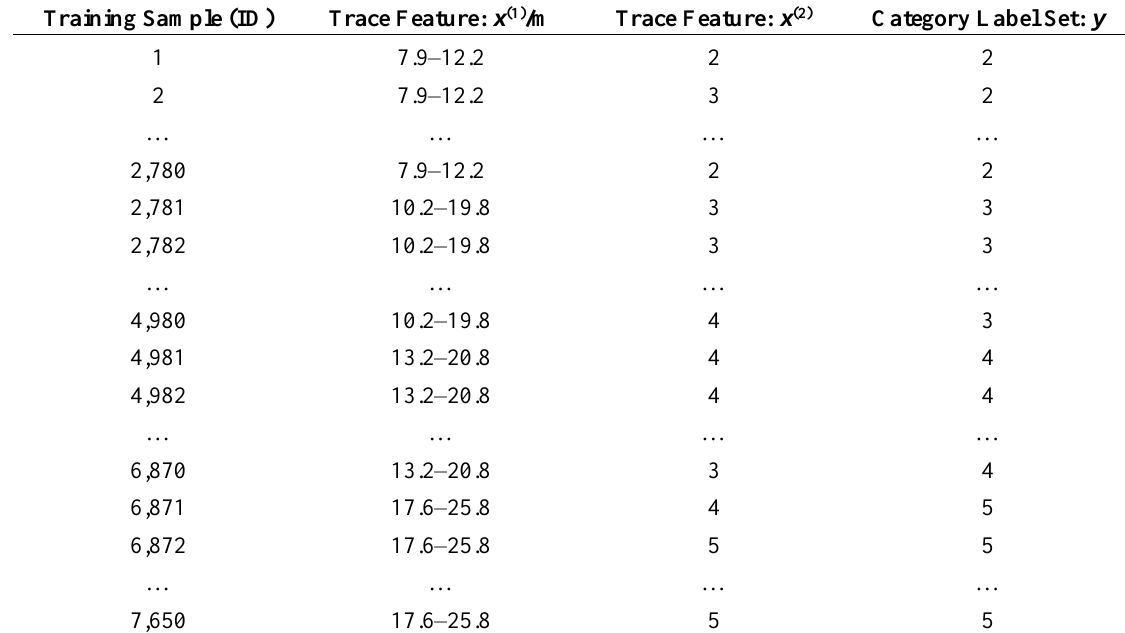
Table 1. Naïve Bayesian classifier.